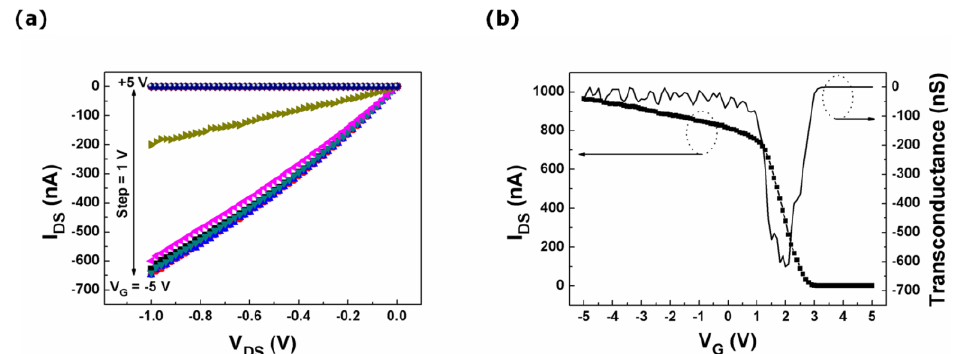
Figure 4. The electrical characteristics of the p -type Si NWs-FET. (a) The output characteristics and (b) the transfer characteristics (left axis) and the transconductance curve (right